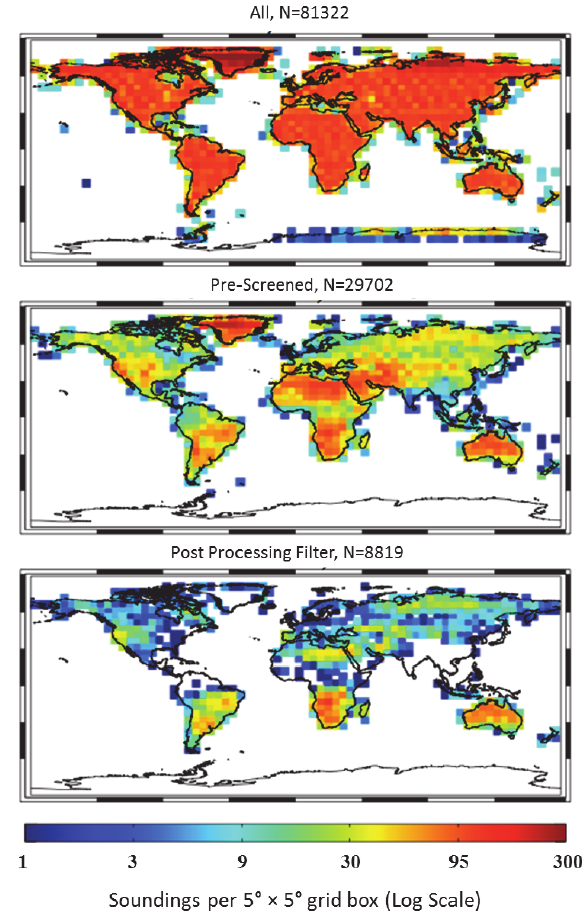
Fig. 9. The spatial coverage for all GOSAT TANSO-FTS soundings Figure 9. The spatial coverage for all GOSAT TANSO-FTS soundings over land from July 3 over land from July 2009 (top) is compared to that for soundings 2009 (top) is compared to that for soundings that pass the pre-screening (cloud and latitude) 4 that pass the pre-screening (cloud and latitude) filters (middle) and filters (middle) and all post-processing filters listed in Table 4 (bottom). 5 all post-processing filters listed in Table 4 (bottom).